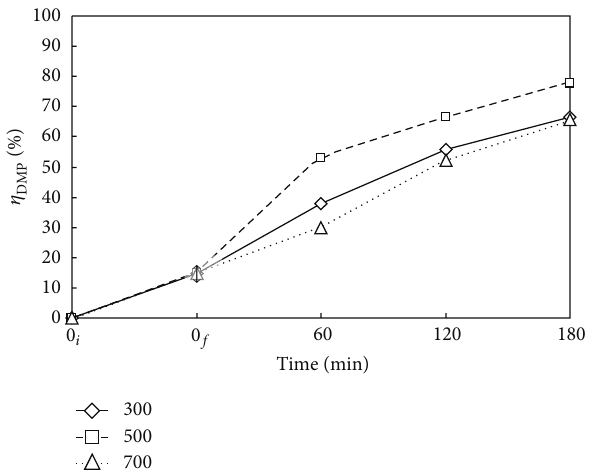
Figure 2: Time variation of decomposition efficiency of DMP ) via WOP at various rotating speeds Nr. ⬦ , ◻ , and △ : Nr = (𝜂 DMP 300, 500, and 700 rpm. 𝐶 0 = 100mg L −1 , 𝑉 𝐿 = 400 mL, 𝑇 = 473 K, and 𝑃 𝑇 = 2.41 MPa. Working gas after time = 0 𝑓 is O 2 . ↕ : Mean and Standard deviation (SD, 𝑛 − 1 method) at 𝑡 = 0 𝑓 : 14.8 ± 2.8.